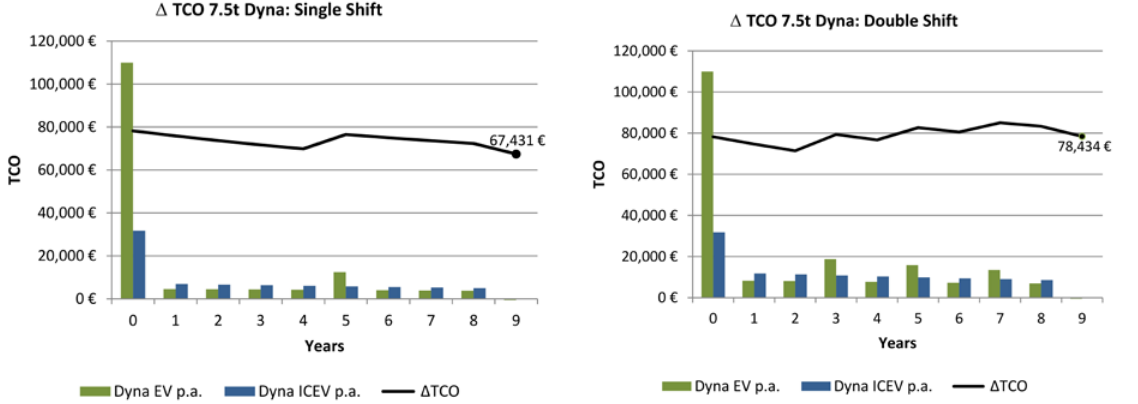
Figure 3. TCO difference of the conventional 7.5 ton Dyna 200 and Dyna EV